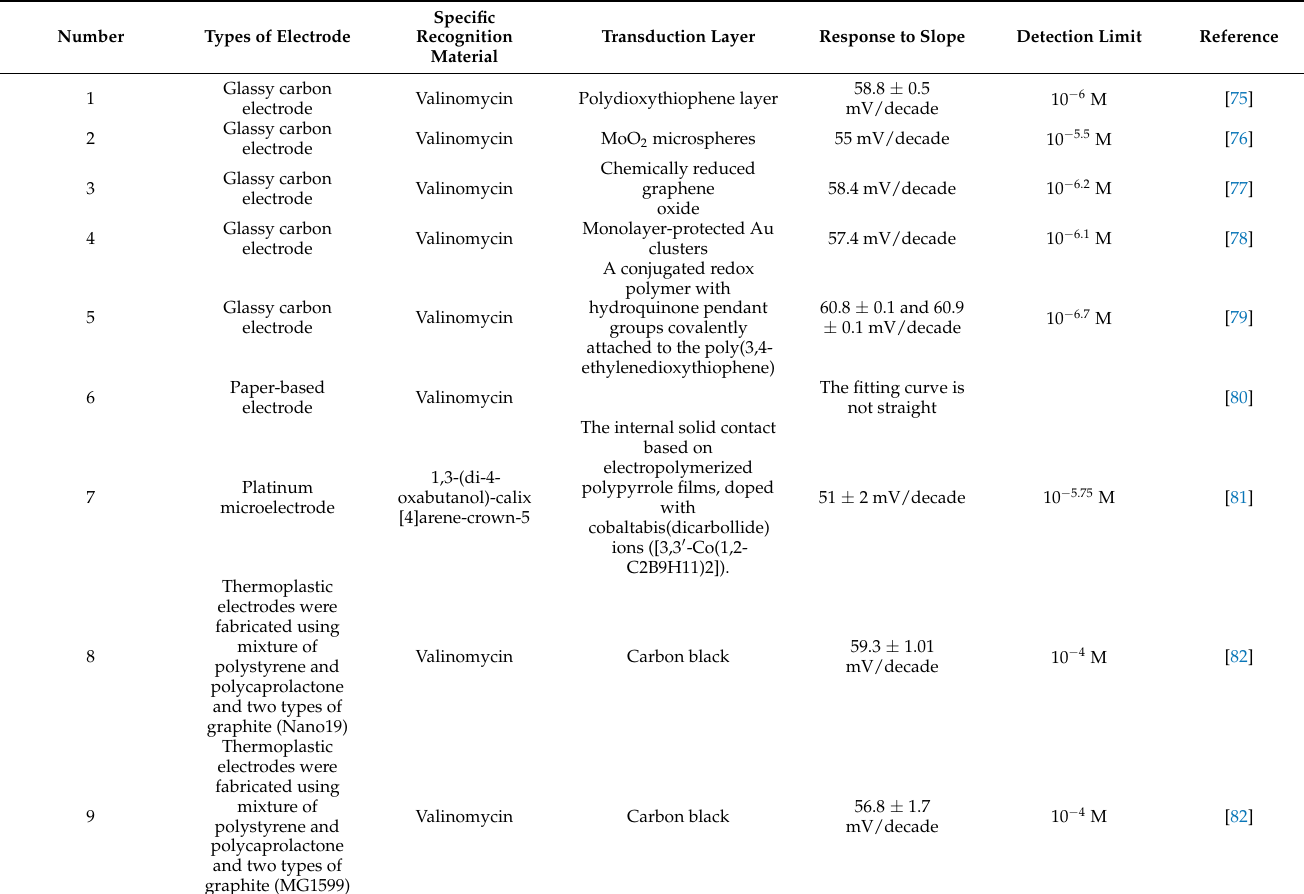
Table 1. List of potassium ISE research status.